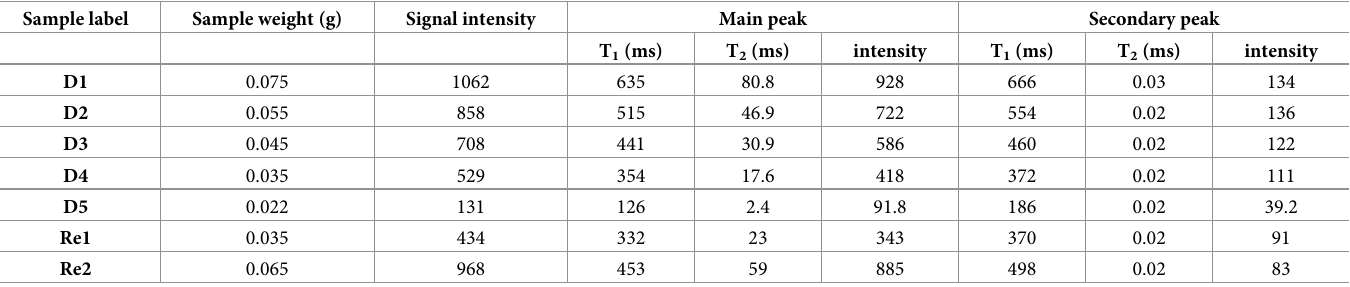
Table 2. T 1 and T 2 values of 1 H nuclei for the two peaks identified via 2D ILT in all cartilage samples, from completely hydrated, to completely dry, then rehydrated (Re1, Re2). Sample